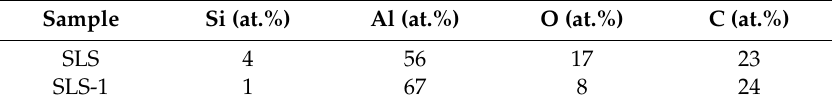
Table 1. EDX atomic concentration in SLS and SLS-1 samples.